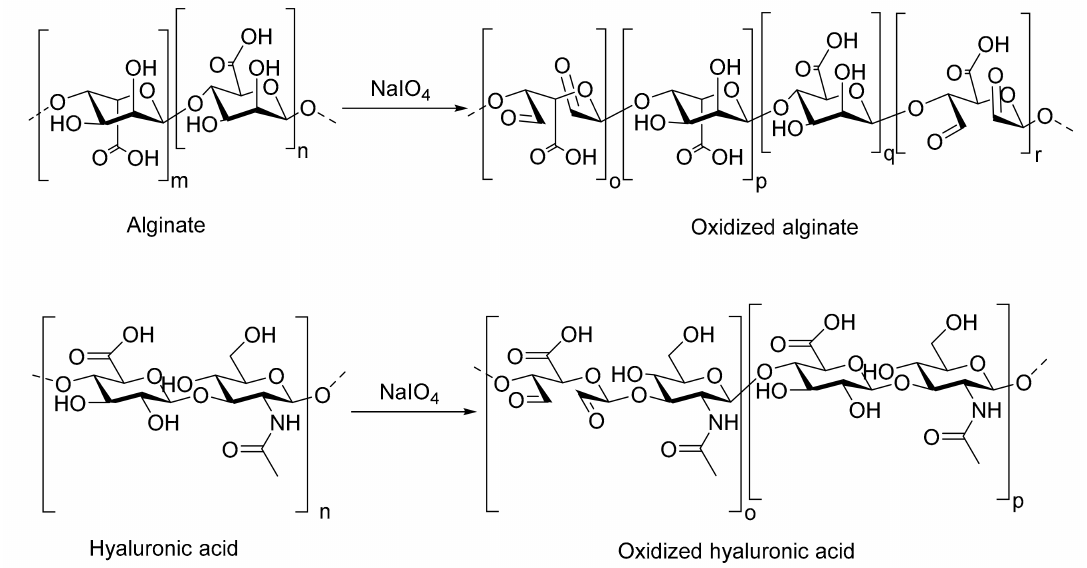
Figure1. Sodium periodate-mediatedoxidation of alginateand hyaluronicacid. The small letters denote the number of repeating units of β - d -mannuronate ( m ), α - l -guluronate ( n ; upper part), and hyaluronic acid ( n ; lower part); the letters o and r denote the number of repeating units for the units of the polysaccharide chain that were oxidized by NaIO 4 , while the letters p and q denote the number of repeating units in the polymer chain, that were not